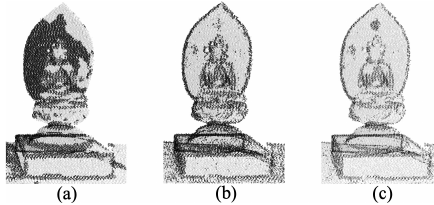
Figure 16. Comparative visualizations with different 3D feature values: (a) change of curvature, (b) linearity, (c)